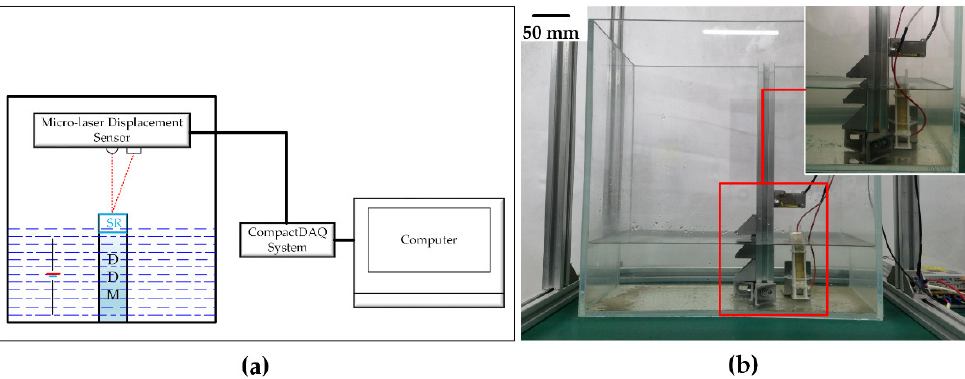
Figure 4. Underwater displacement characteristics test bench: ( a ) Schematic of underwater displacement characteristics testing system, and ( b ) underwater displacement characteristics test site.